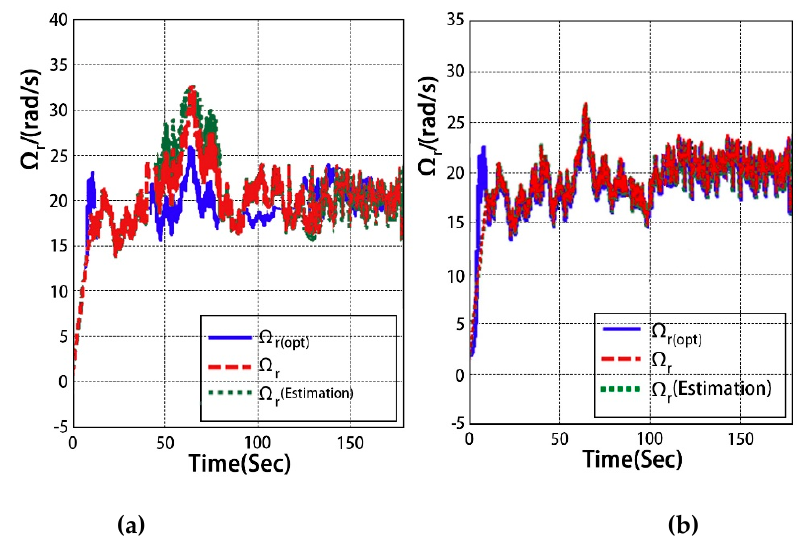
Figure 7. The trajectories of strategy. Figure 7. The trajectories of Ω r . ( a ) Without using the FRSFTC strategy; ( b ) Using the FRSFTC strategy. Figure 7. The trajectories of strategy.